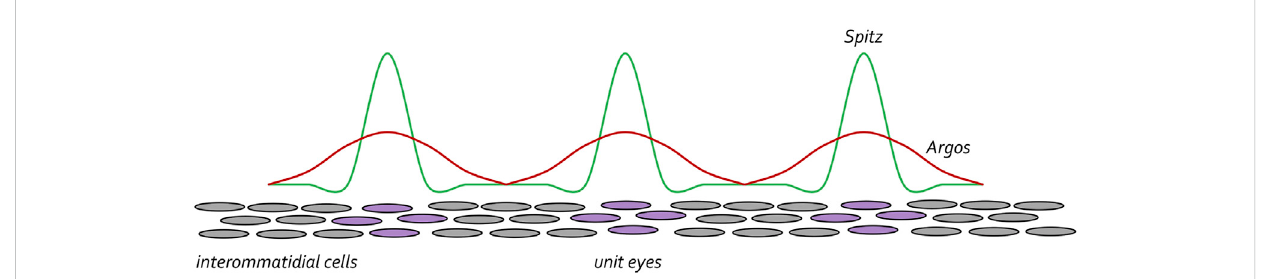
FIGURE 13 The EGF receptor pathway maintains spacing between developing ommatidial clusters. Once the R8 cell is speci fi ed the EGFR pathway is then reiterativelyused tospecifytheremainingphotoreceptorneurons(purplecircles).StartingwiththeR8cell,eachphotoreceptorsecretes theSpitzligand. This activating morphogen is expressed at high levels but only travels short distances. The photoreceptor cells also secrete the Argos inhibiting morphogen. It is expressed at lower levels than Spitz but travels farther. The differences in levels and distance travelled by the two morphogens ensures that the unit eyes are spaced at periodic intervals. This is reminiscent of the diffusion-reaction model that was proposed by Alan